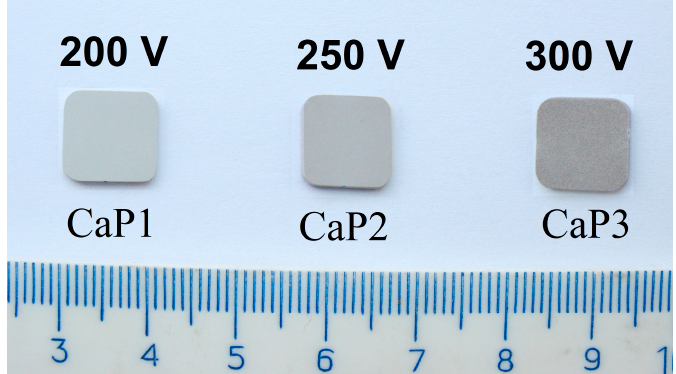
Figure 3. Photographs of the calcium phosphate (CaP) coatings synthesized on titanium at different process voltages of the micro-arc oxidation (MAO).